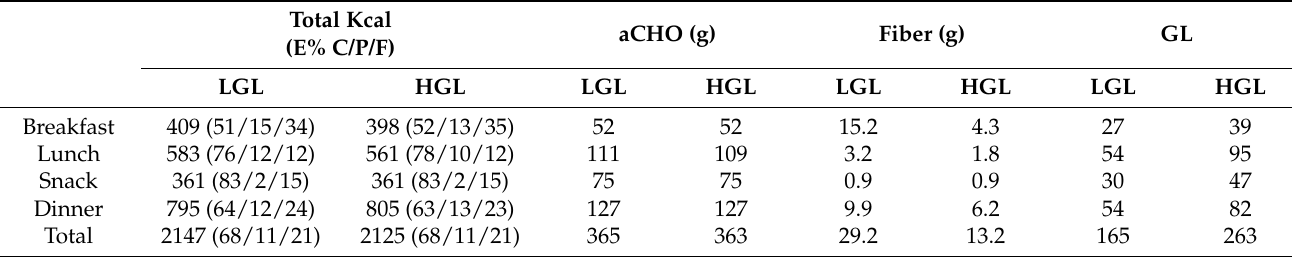
Table 1. 24 h diet macronutrient and energy composition.